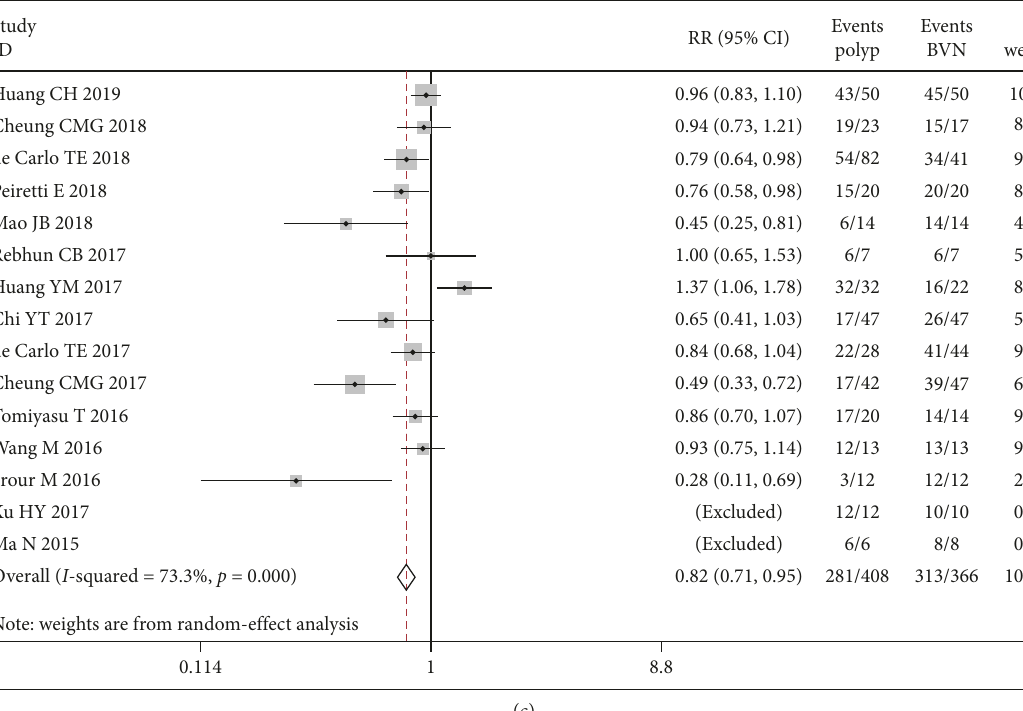
Figure 2: Forest plot showing the PCV lesion detection rate. The combined detection rate of polyps (a) and BVNs (b) and the relative risk (RR) of comparing the detection rates of polyps and BVNs (c). BVN: branching vascular network; CI: confidence interval; RR: relative risk. RR was calculated using a random-effect model (DerSimonian–Laird